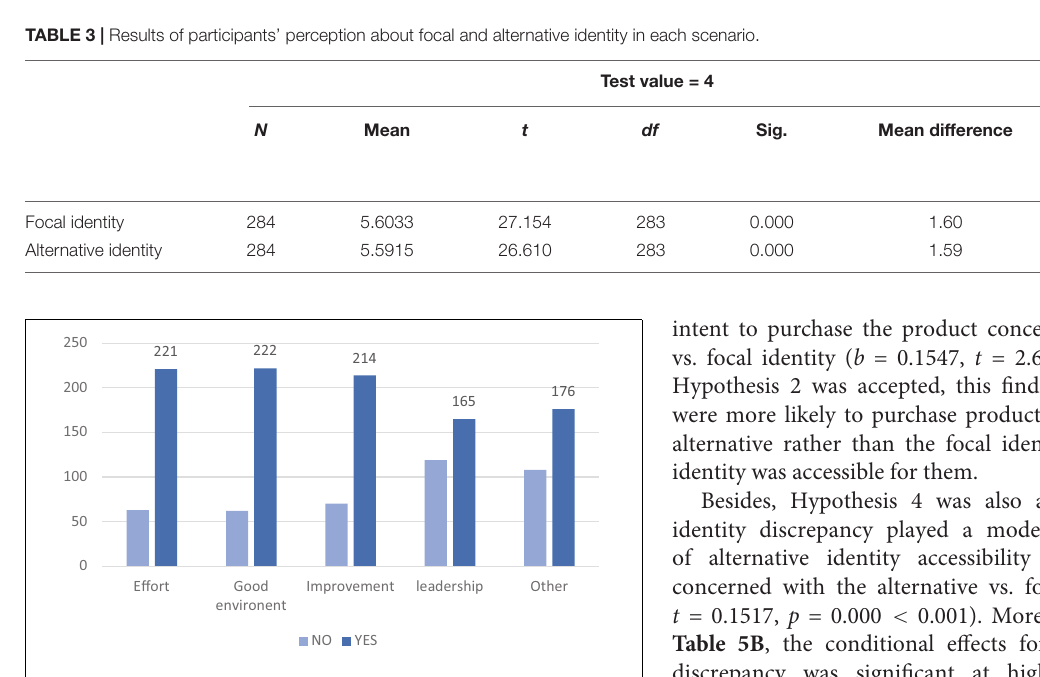
FIGURE 2 | Results of participants’ thoughts about similarity or